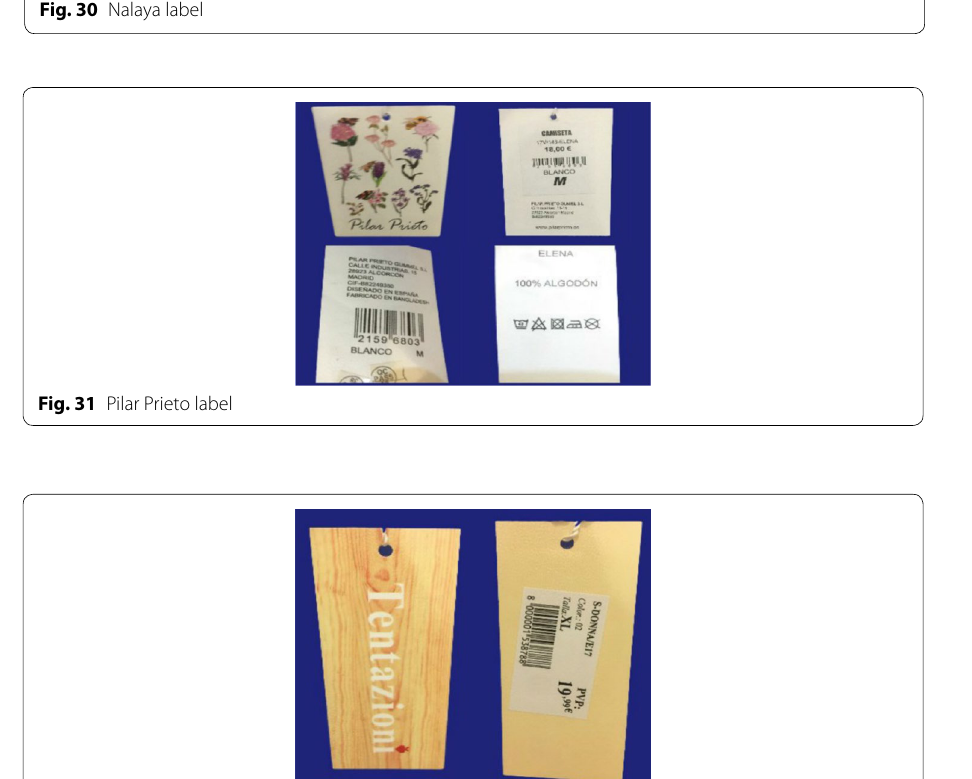
Fig. 30 Nalaya label